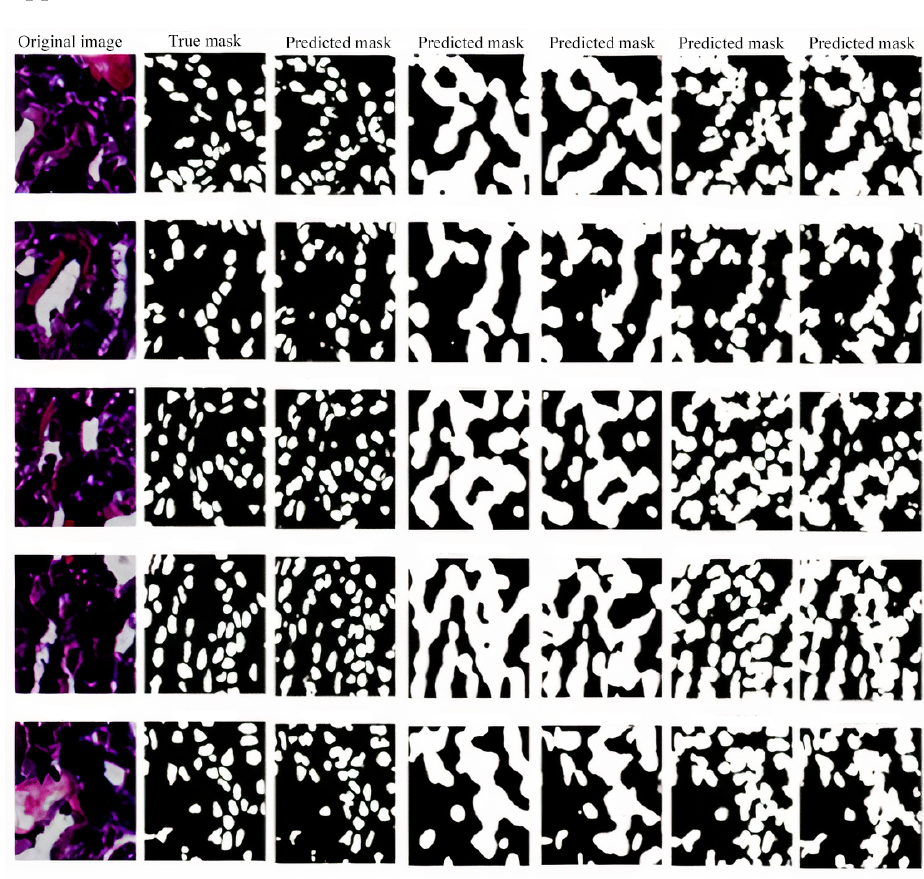
Figure A1. From left to right: The original image, the true mask, the predicted mask by the proposal, U-Net, LinkNet, SegNet, and ENet (see section for detailed